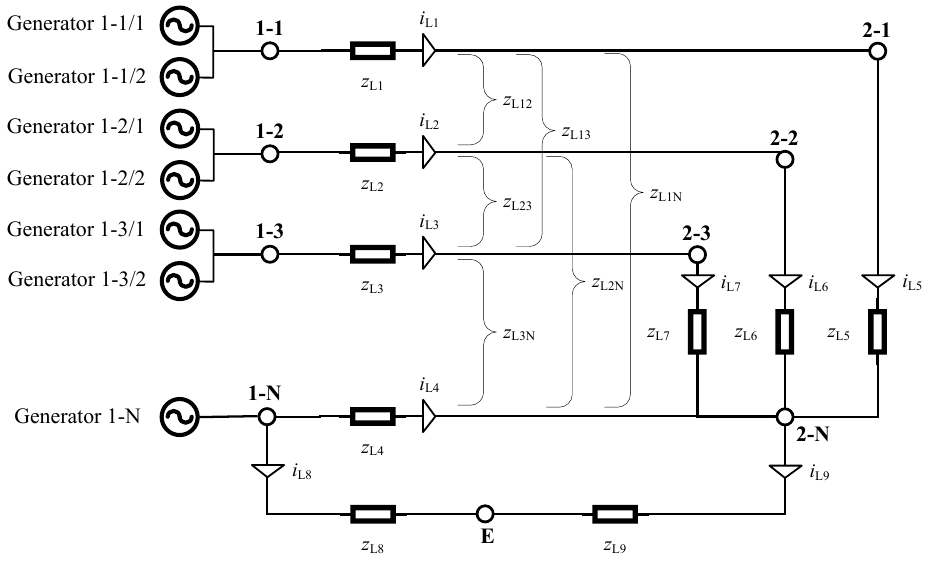
Figure 10. Model of the grid for three-phase OPF